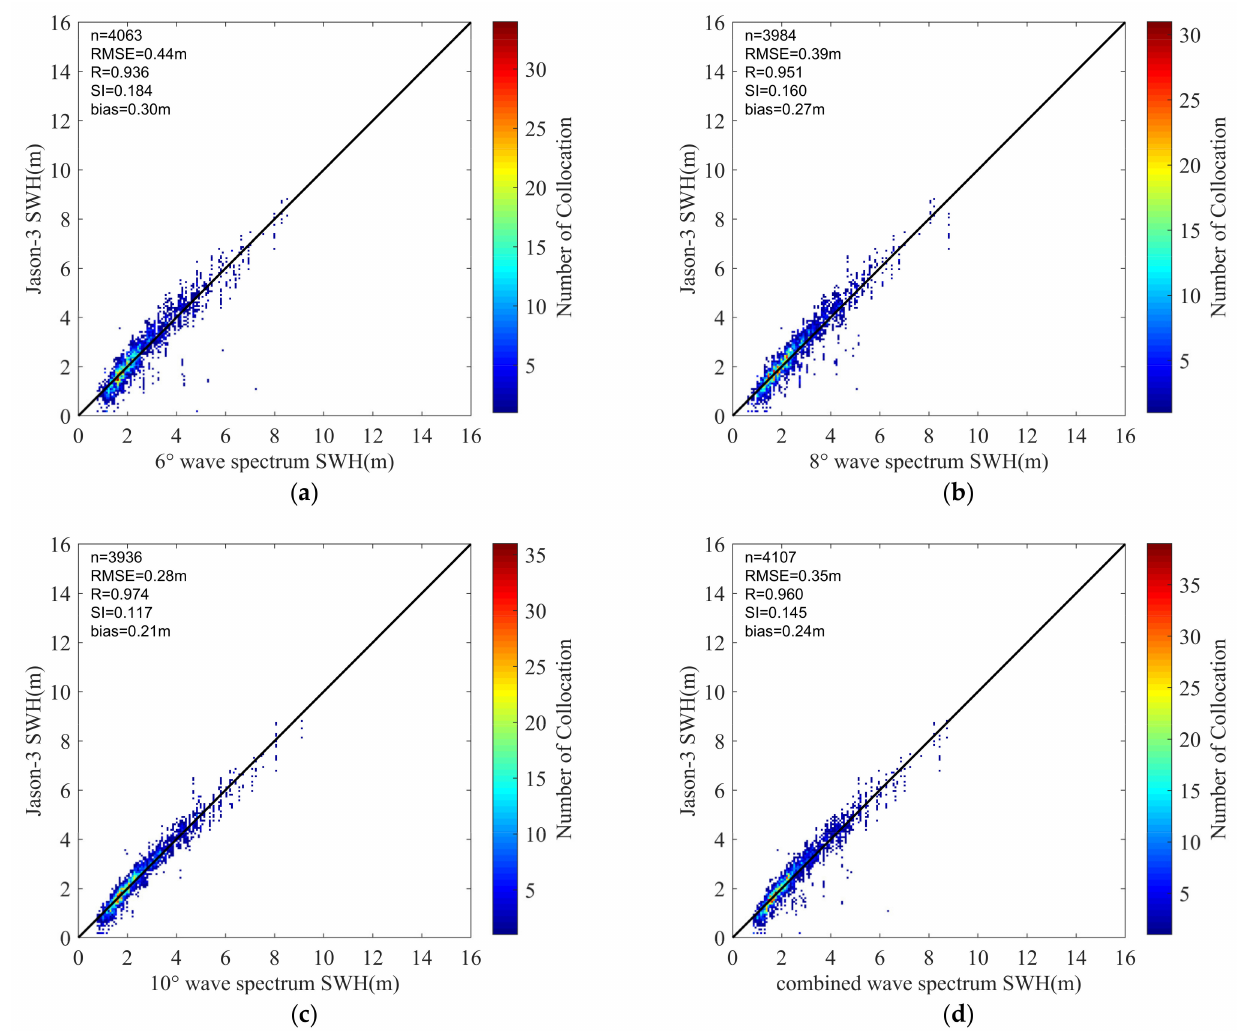
Figure 10. Wave spectrum SWH from Jul. to Sep. 2020 compared with Jason-3: ( a ) 6 ◦ wave spectrum, ( b ) 8 ◦ wave spectrum, ( c ) 10 ◦ wave spectrum and ( d ) combined wave